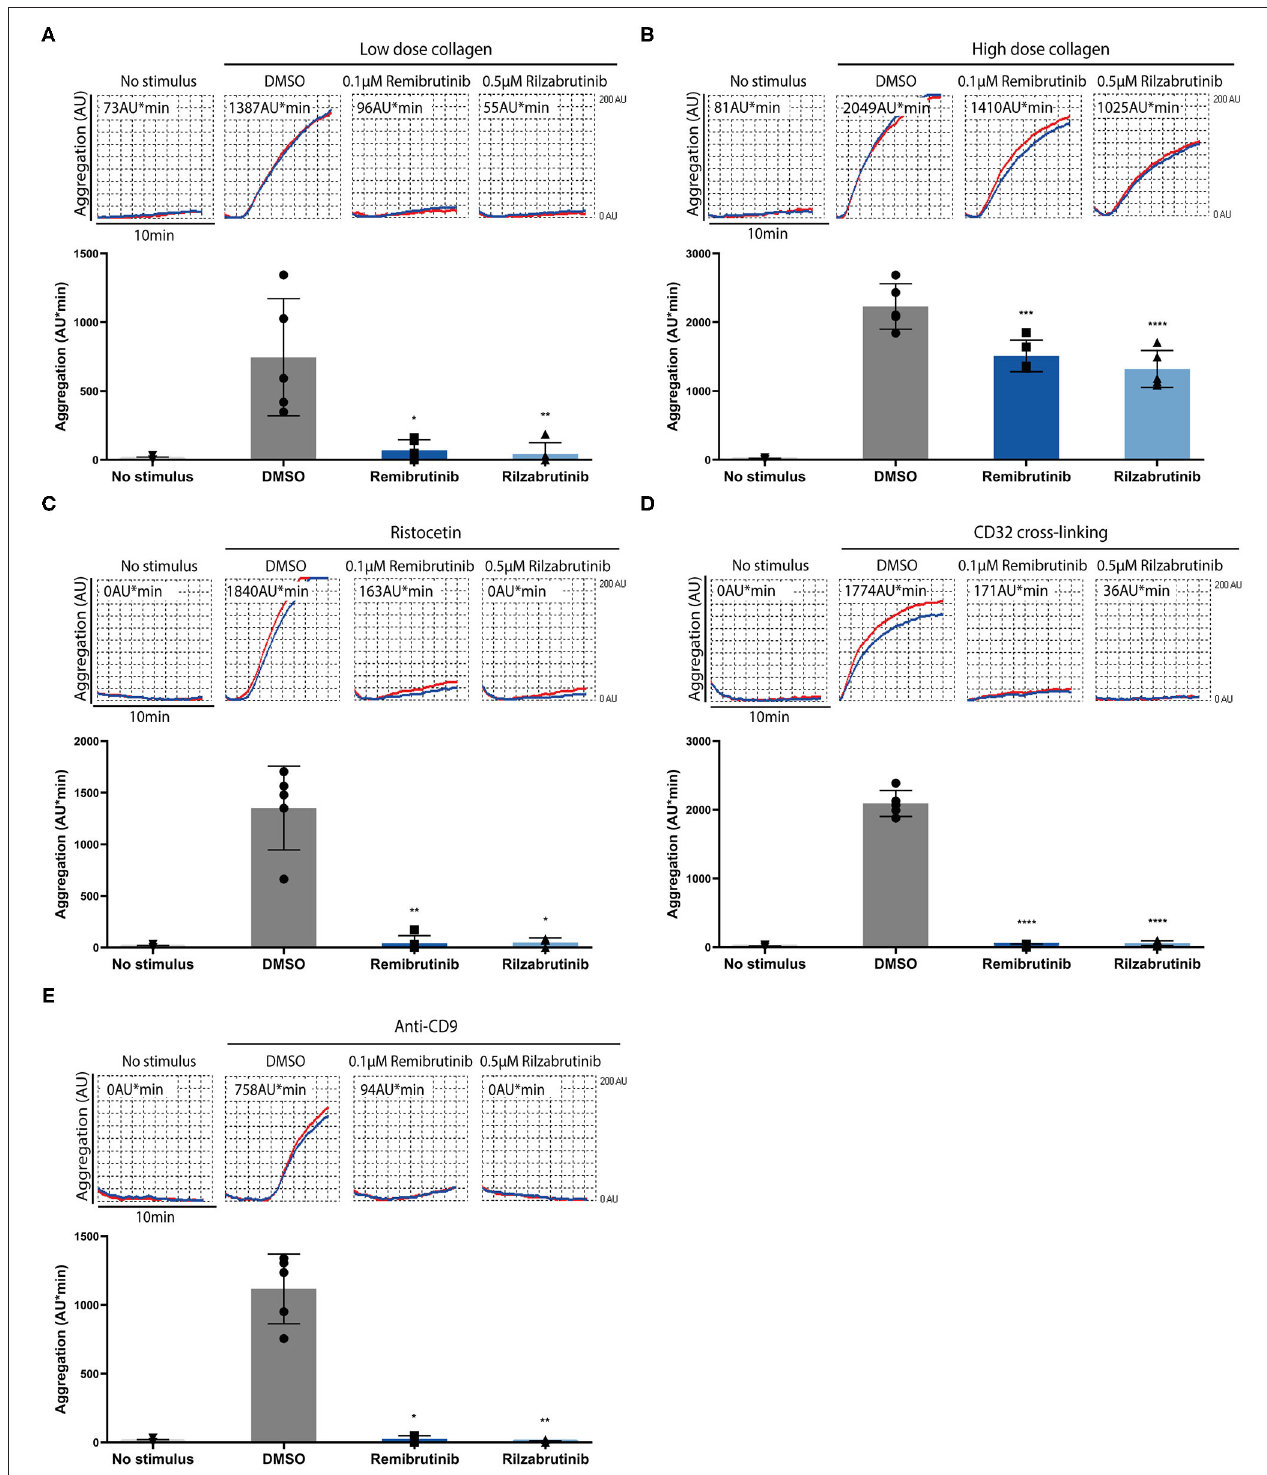
FIGURE 2 | Effects of remibrutinib and rilzabrutinib on platelet aggregation in blood after stimulation by collagen, ristocetin or Fc γ RIIA activation. Hirudin anticoagulated blood was preincubated for 1h with DMSO or BTKi (remibrutinib 0.1 µ M, rilzabrutinib 0.5 µ M) prior to stimulation with (A) low dose collagen (0.4–0.6 µ g/ml) that was titrated to induce a similar degree of platelet aggregation as plaque homogenate (833 µ g/mL) (19), (B) high dose collagen (4–6 µ g/ml) that was 10 × concentrations of the low dose collagen (8, 19), (C) ristocetin (0.5 mg/ml), (D) CD32 cross-linking (3min incubation with 2 µ g/ml AT10, plus 30 µ g/ml